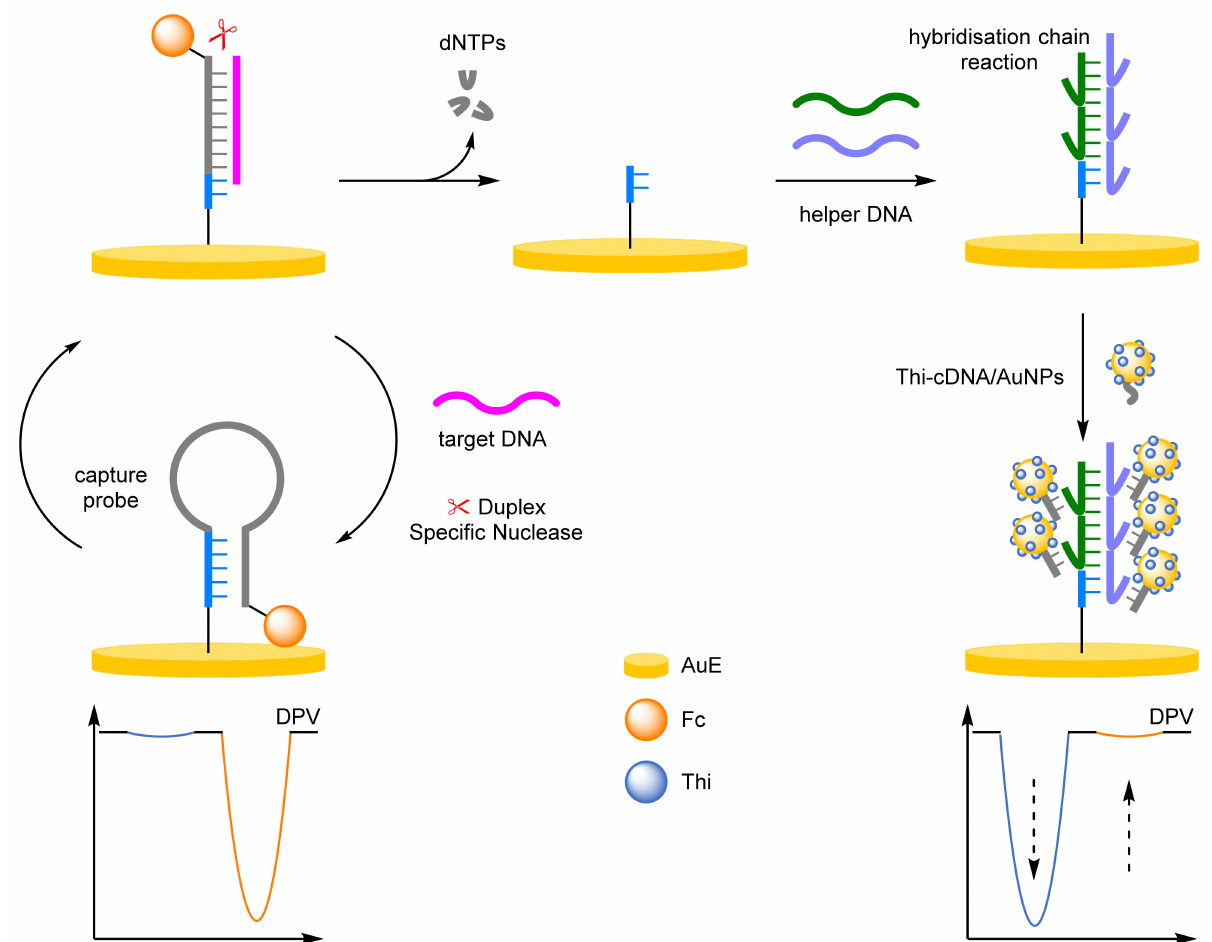
Figure 24. Schematic representation of a hybridisation chain reaction-based biosensor with nanoparticle-assisted label am-